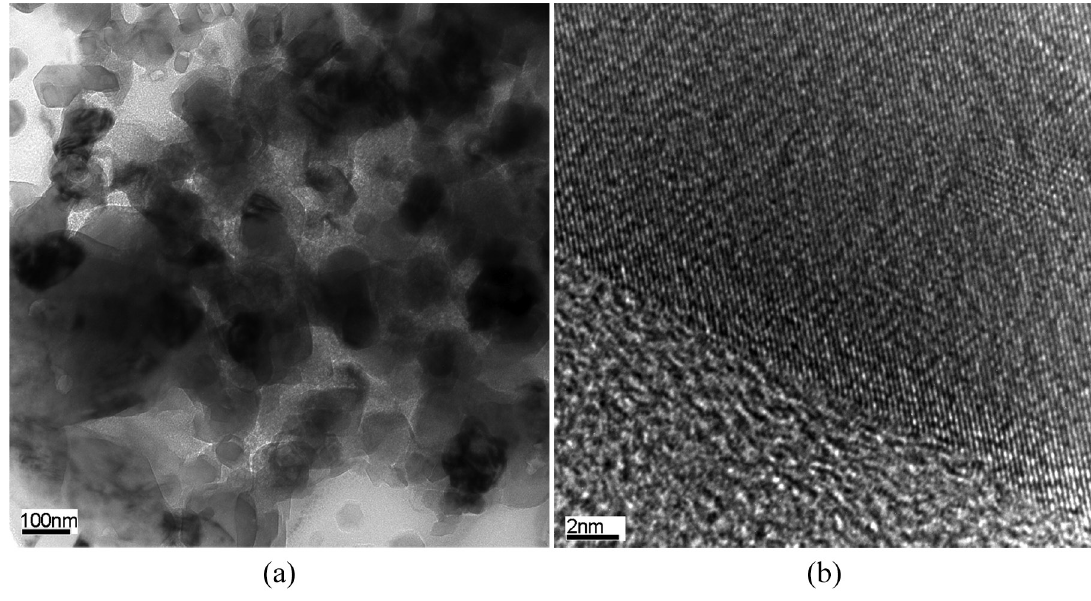
Figure 5. TEM images of (a) nanostructured Al